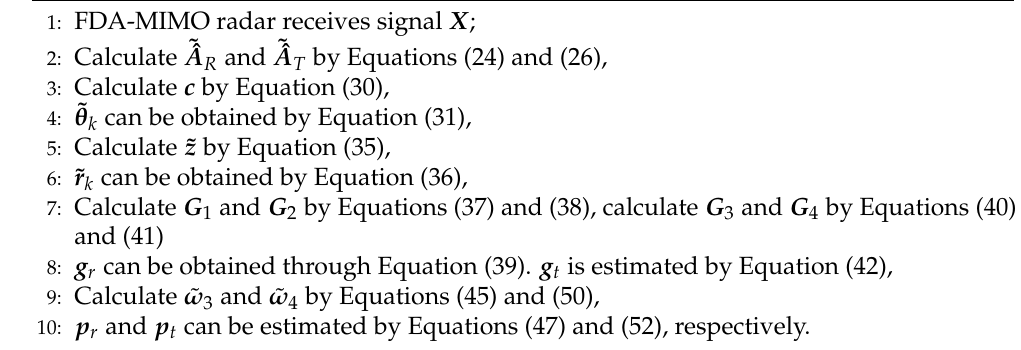
Algorithm 1 Tensor-based target parameter estimation algorithm for FDA-MIMO